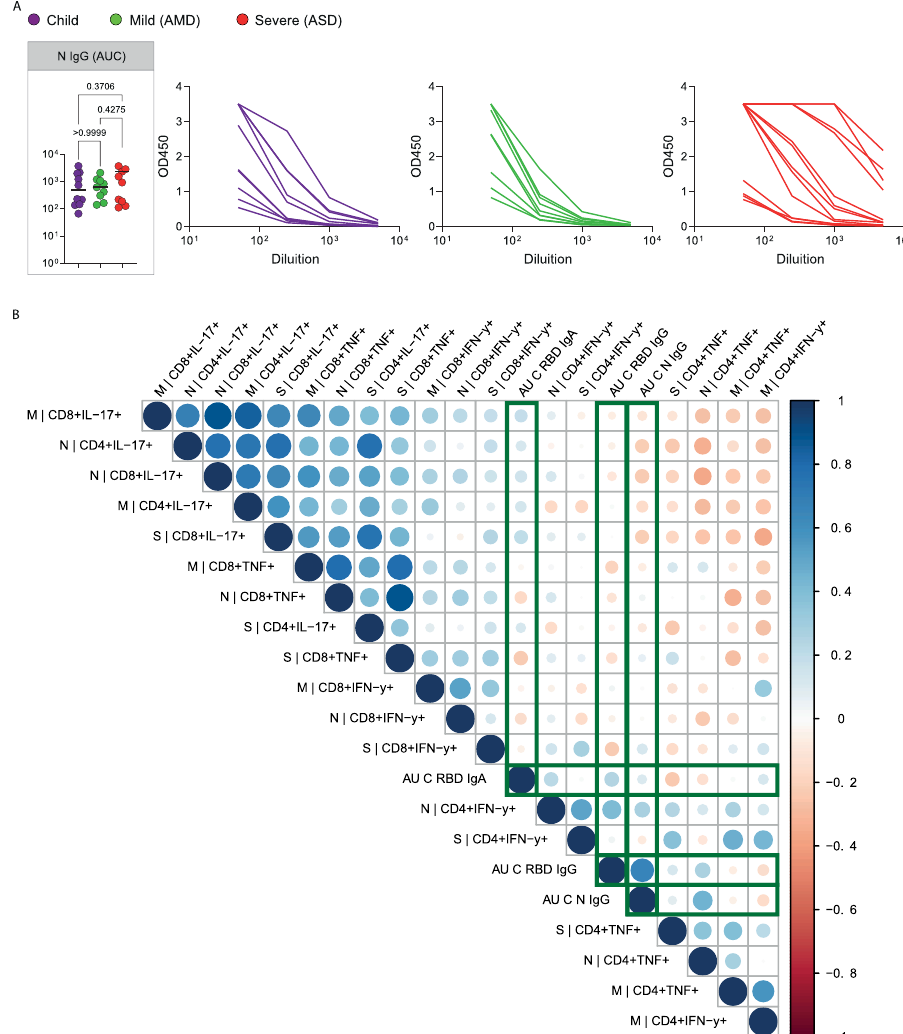
Fig. 6 Anti-N IgG response and correlation of speci fi c responses. A SARS-CoV-2 anti-N IgG antibody titers determined by ELISA using serial dilutions of plasma. Individual titration curves for individuals (represented by a line, color coded) and analysis of variance (Kruskal – Wallis) of the values calculated as the area under the curve (AUC) for IgG ( A ) are displayed. P values are displayed over brackets, the horizontal bar representing the median. B Matrix representing a Spearman correlation analysis of speci fi c effector T cells responses (in percentages of CD4 + and CD8 + cells expressing citokines in response to peptide pools) and the antibody response to the RBD of the spike protein and to the N protein (represented as values for the AUC). Correlations between the speci fi c effector CD8 + T and CD4 + T cells frequencies, and the antibody (AUC — area under the curve) values for the RBD and N protein are highlighted. Source data are provided as a Source Data fi le. n children = 10, n AMD = 9, n ASD =